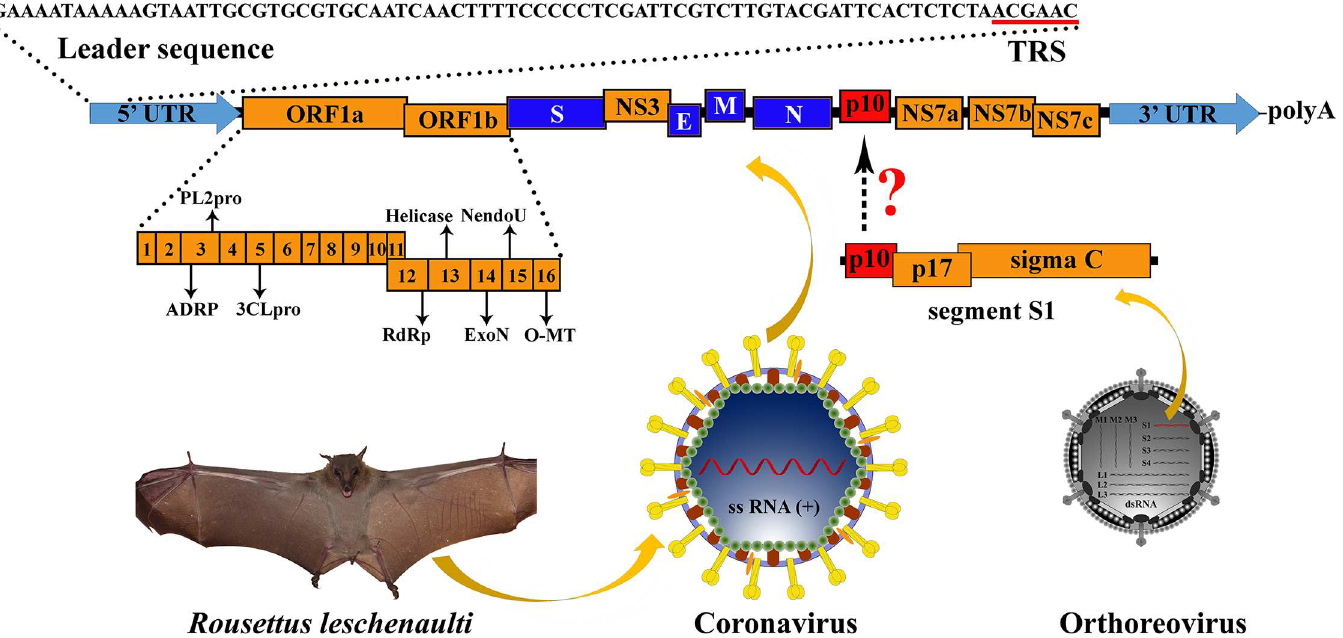
Fig 1. Genomeorganizationand phylogenetichistoryof Ro-BatCoVGCCDC1. Genomeorganizationof Ro-BatCoVGCCDC1. Nonstructural genes and putative maturenonstructural proteins,structural genes, and 5’- and 3’-UTRare illustratedwith yellow, darkblue and light blue colors, respectively. The remarkablep10 gene is shown in red. The potentialoriginof the p10 gene is indicated by a dottedarrow and a questionmark.The leadersequence and leadertranscription regulatorysequence(TRS)are directlyshown with nucleobases. The bat, Rousettus leschenaulti ,is used to show the host species that Ro-BatCoVGCCDC1 was discovered. The schematicvirionof coronavirusis used to show the virusthat identifiedin the presentstudy. The schematic virion of orthoreovirus and the segmentS1 of the genomethat it contains are used to demonstrate the possible originof the p10 gene.